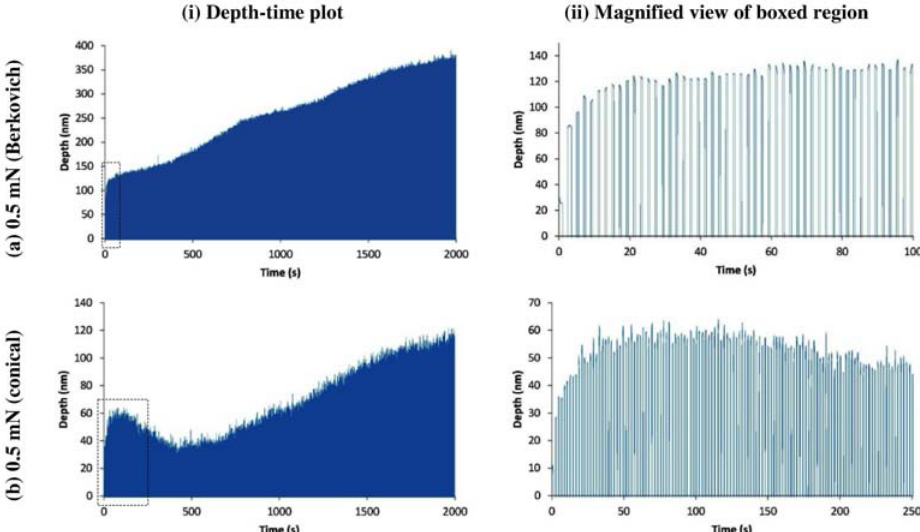
Figure 3. Nano-impact testing at 0.5 mN load: ( i ) Full record of impact depth-time measurement; ( ii ) corresponding magnified boxed-view of early stage of impacts.